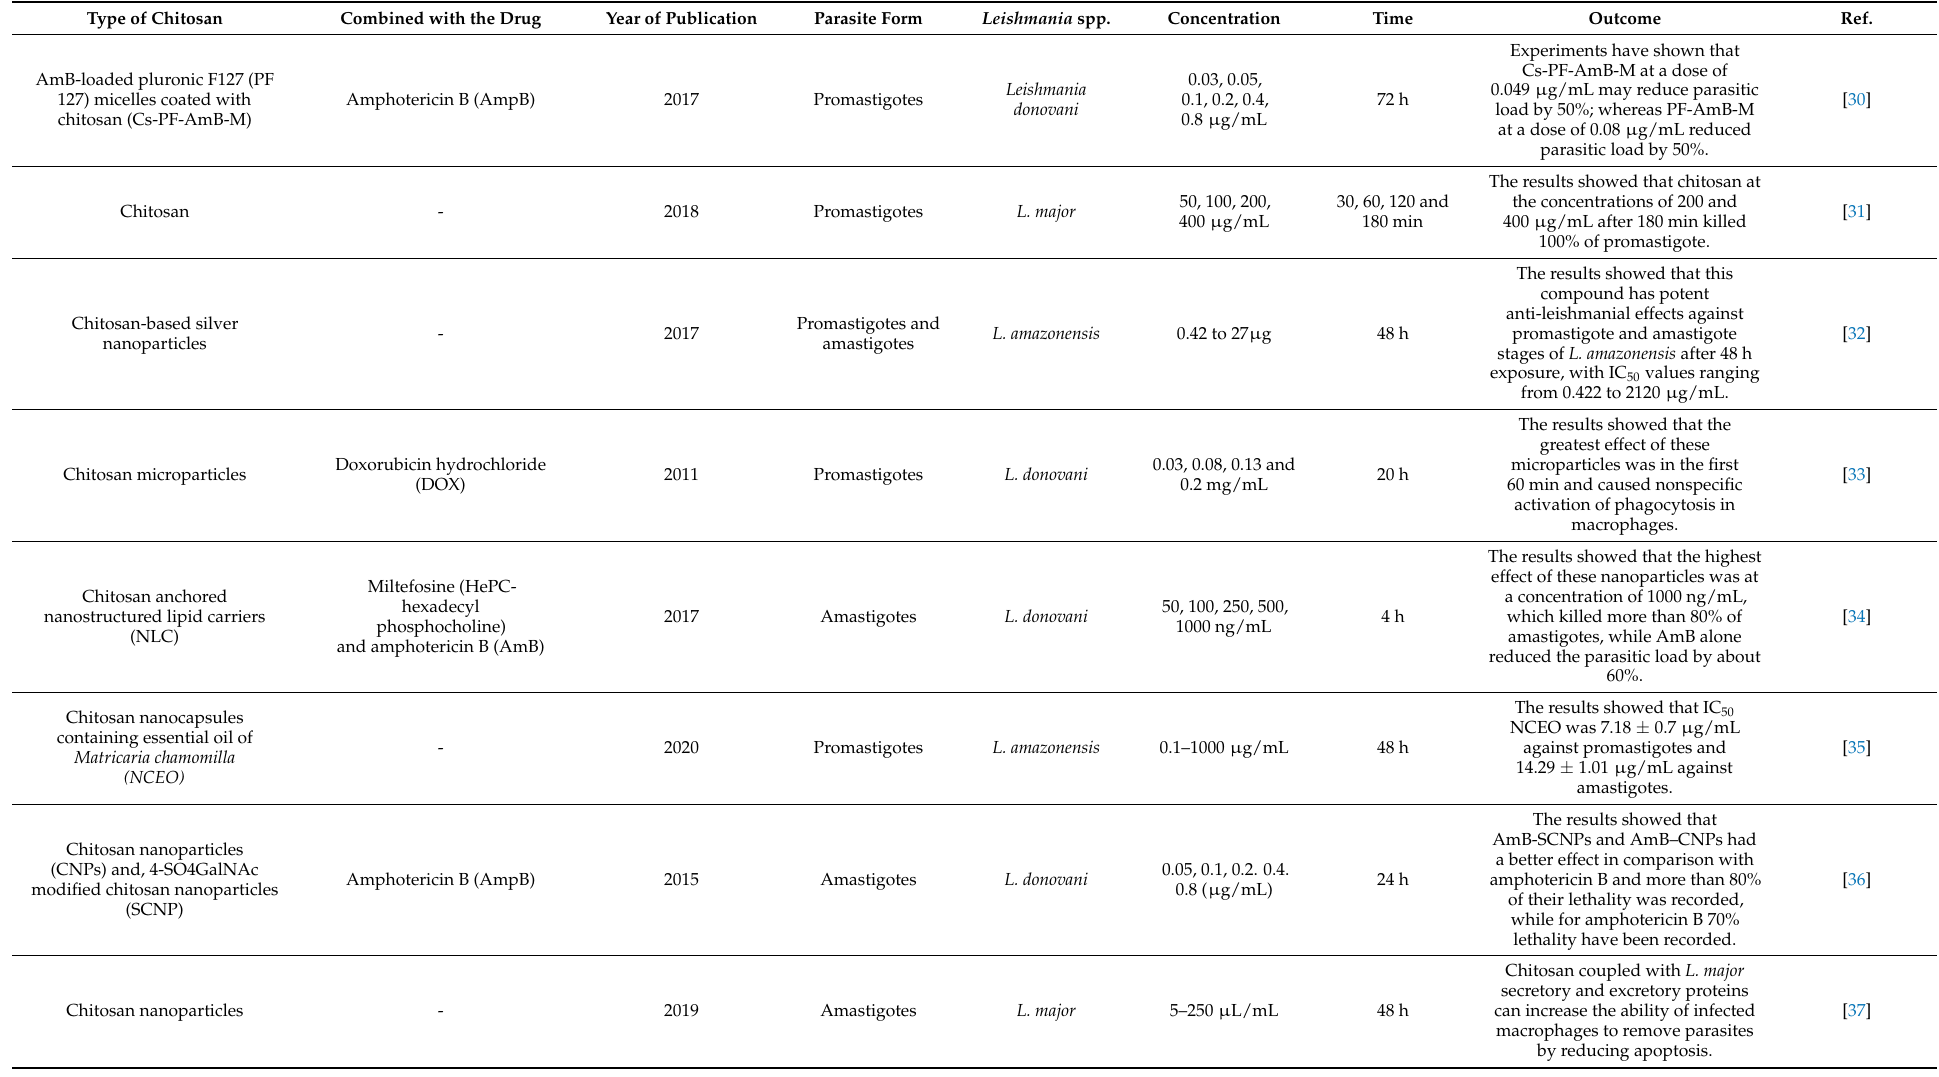
Table 1. A list of in vitro studies of chitosan and its derivatives as resource for anti-leishmanial agents.